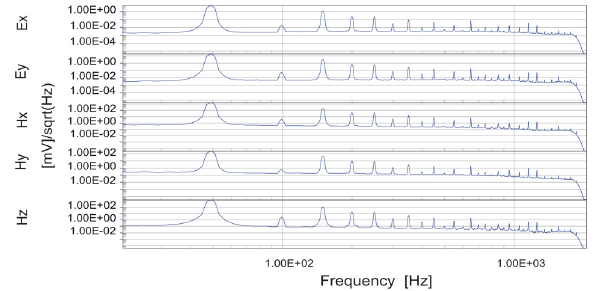
Figure 5. Stacked spectra of 4 KHz data set showing the presence of powerline frequency (50 Hz) and its harmonics (150 Hz, 250 Hz, ...) on the